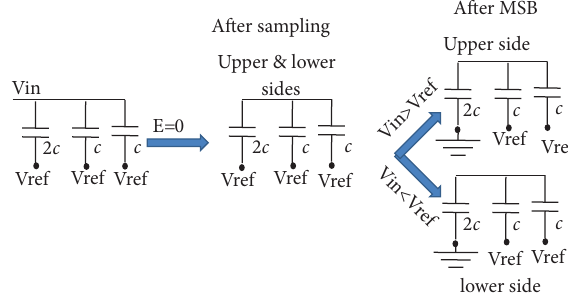
Figure 27: Te monotonic voltage switching scheme.